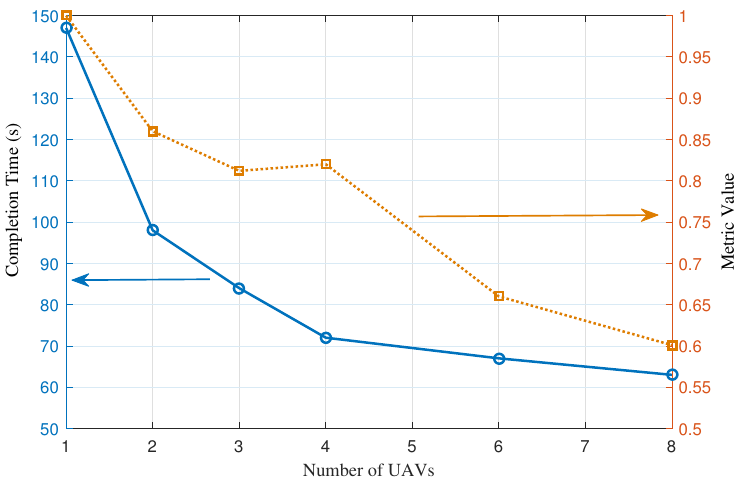
Figure 12. The relationship between the network efficiency and the resource metric value in the multi-UAV